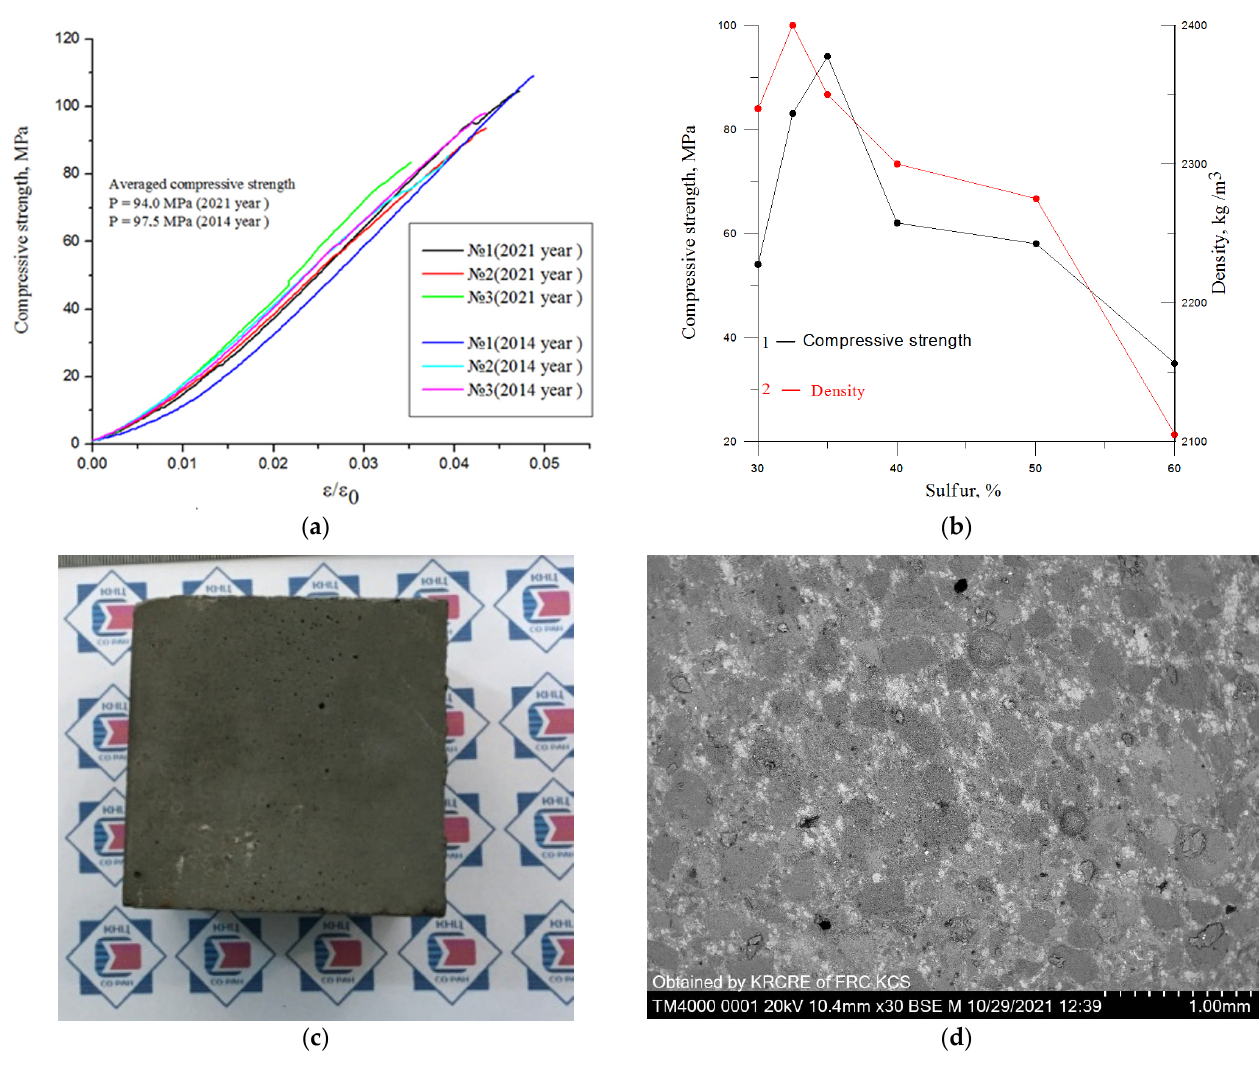
Figure 7. Compressive strength test results for a sulfur/marshalite composite (35%/65) ( a ), dependence of strength and density on sulfur concentration ( b ), photographs of a sample obtained in 2014 (2-column fitting image), sample obtained in 2014 and tested in 2021 ( c ), samples after testing ( d ).